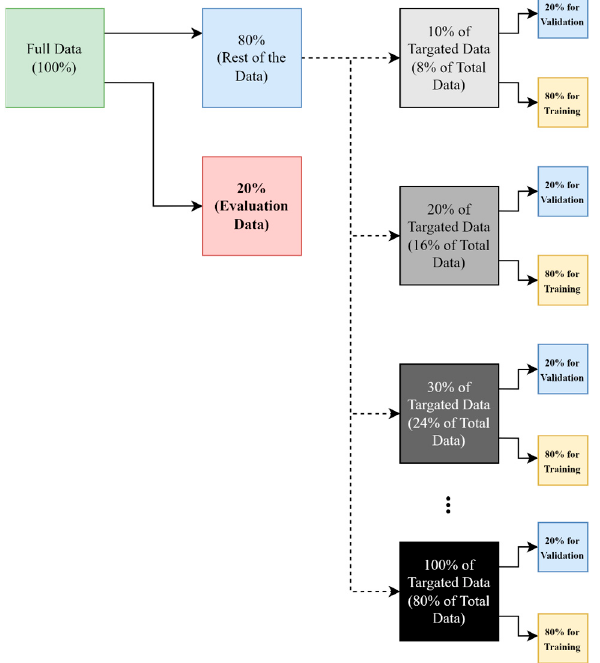
Figure 7. Randomly splitting process of selected dataset, for creating the training, validation, and test (evaluation) datasets. (evaluation) datasets.